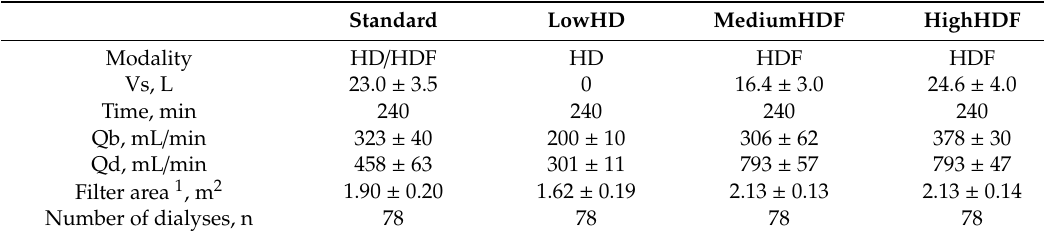
Table 3. Dialysis treatment settings.